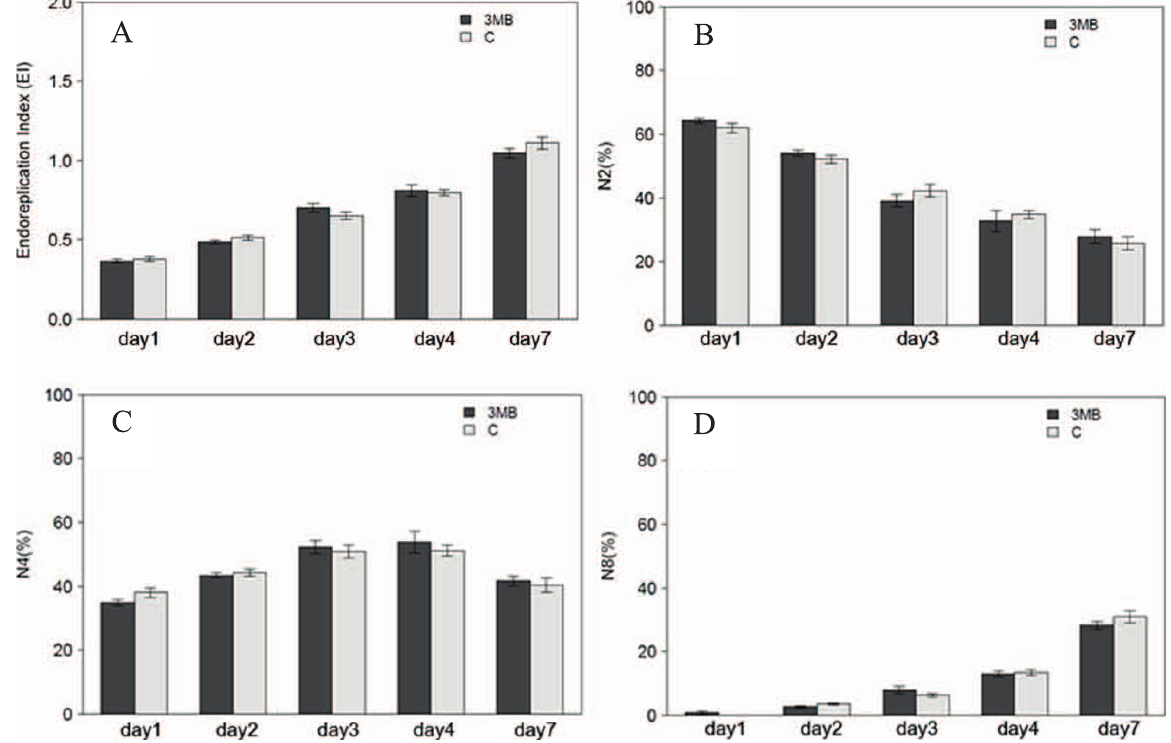
Figure 5. Ploidy analysis of leaf two. Arabidopsis leaf two was analyzed at the indicated time points from plants subjected to PARP inhibition or control conditions. (A) the calculated EI is shown, EI represents the number of endo cycles undergone by a typical nuclei (EI = 1*4N + 2*8N + 3*16N), in (B–D) percentage of 2N, 4N and 8N nuclei is presented. 10–12 leaf two were pooled for a replicate, four biological replicates were analyzed in each of the two independent experiments (n=8).